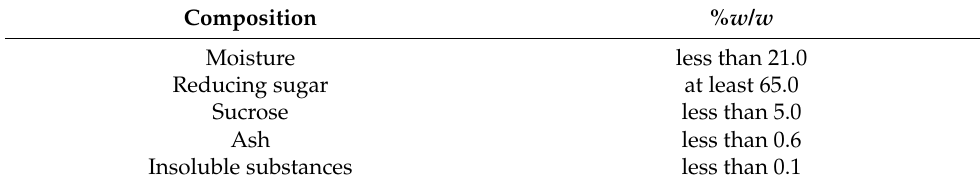
Table 1. Honey standards of Thailand [16].